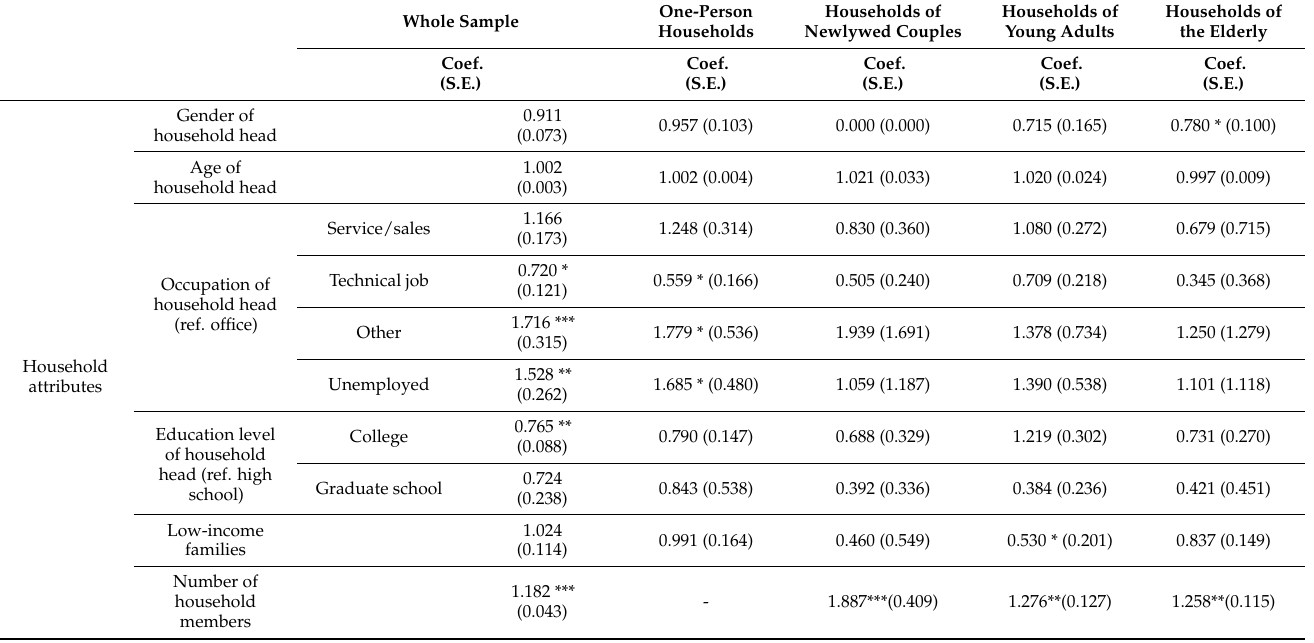
Table 4. Results of housing cost burden